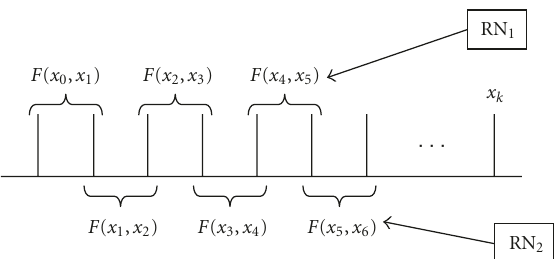
Figure 4: Pairs of symbols alternately transmitted to each relay, according to a bijective function F ( x k , x k +1 ).